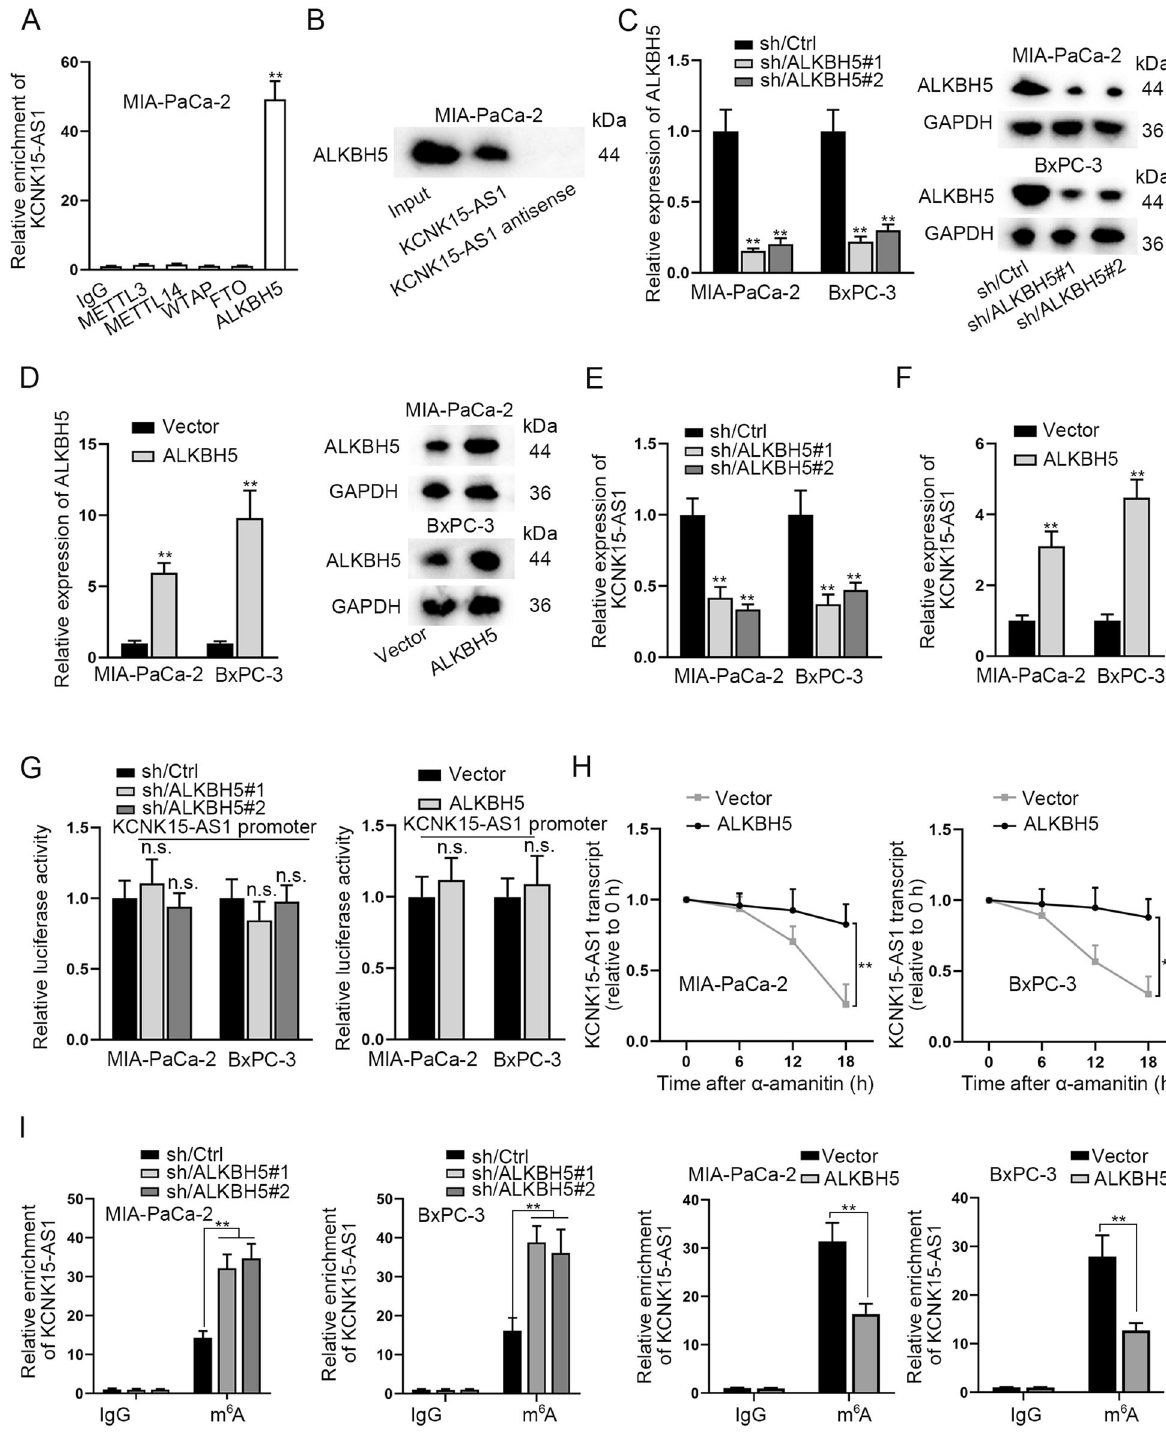
Fig. 3 ALKBH5 binds with and stabilizes KCNK15-AS1 through m 6 A-dependent manner. A Interaction of KCNK15-AS1 with METTL3, METTL14, WTAP, FTO and ALKBH5 in PC cells was measured by RIP assay (IgG served as negative control). B RNA pulldown assay was performed to evaluate the binding of ALKBH5 with KCNK15-AS1 in PC cells. C , D Knockdown and overexpression ef fi ciencies of ALKBH5 were tested by RT-qPCR and western blot in PC cells. E , F KCNK15-AS1 expression in PC cells after ALKBH5 silence or overexpression was examined using RT-qPCR. G Luciferase activity of KCNK15-AS1 promoter was measured in PC cells with ALKBH5 silence or overexpression. H The level of KCNK15-AS1 in indicated PC cells under α -amanitin (50 mM) treatment was measured by RT-qPCR. I RIP assay was carried out to detect the impact of ALKBH5 on m 6 A modi fi cation in KCNK15-AS1 in PC cells. ** P < 0.01, n.s. no signi fi cance.